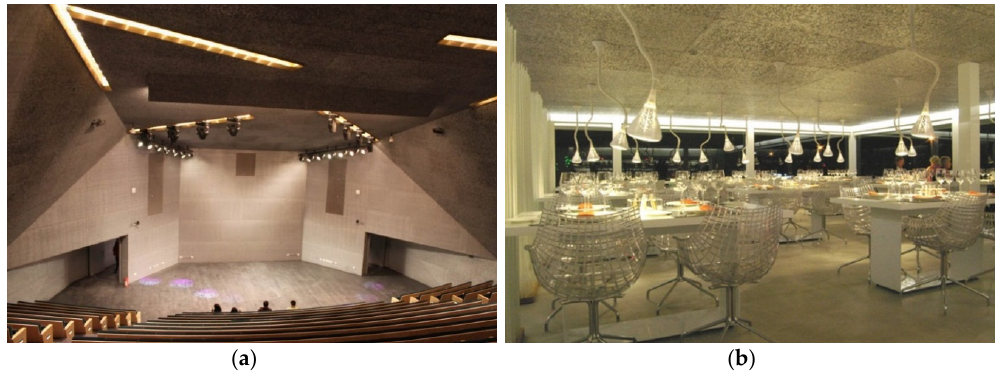
Figure 10. Ceiling of ( a ) audience hall; and ( b ) restaurant covered by Alusion foam for sound control (courtesy of Cymat).